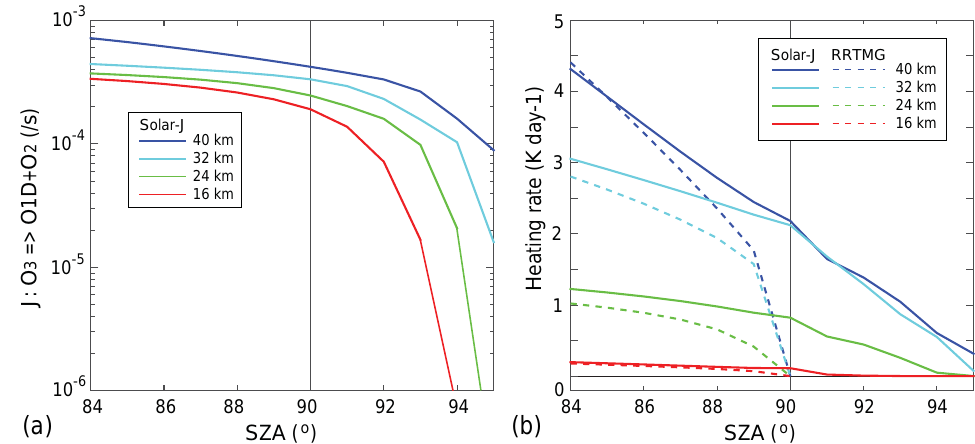
) from Solar-J (a) and the corresponding atmospheric heating rates under clear sky (b) from Solar-J Figure 3. Ozone photolysis rates ( J O 3 (solid lines) and RRTMG-SW (dashed lines) for large solar zenith angles at four different altitudes. RRTMG-SW’s heating rates reduce to zeros at an SZA of 90 ◦ due to the lack of sphericity correction in the plane-parallel approximation, whereas the impact of sphericity on the direct solar beam path is included in